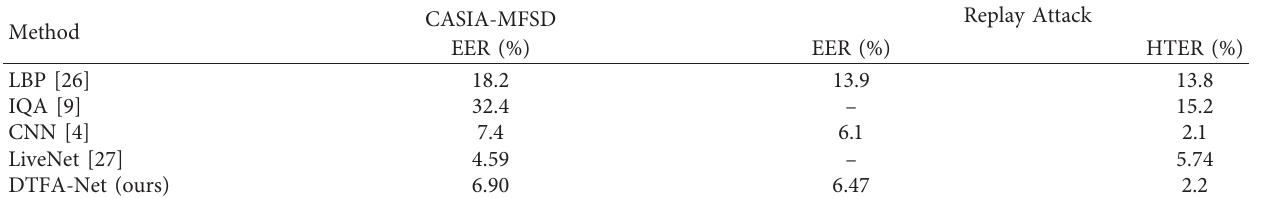
Table 5: Comparison between our proposed method and the other in intradatabase.